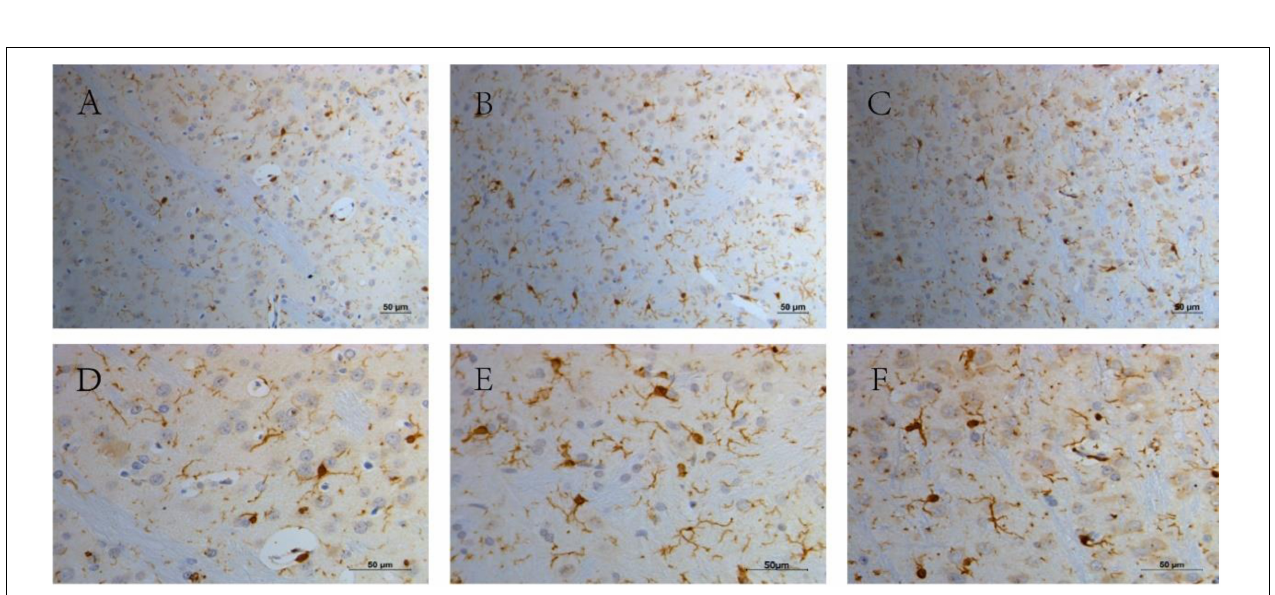
FIGURE 4 | The activated microglia in the striatal area in each group. (A) The CON group (200 × ); (B) the TS group (200 × ); (C) the TS + Hal group (200 × ); (D) the CON group (400 × ); (E) the TS group (400 × ) and (F) the TS + Hal group (400 × ). CON, normal control; TS, Tourette syndrome; TS + Hal, TS + haloperidol.